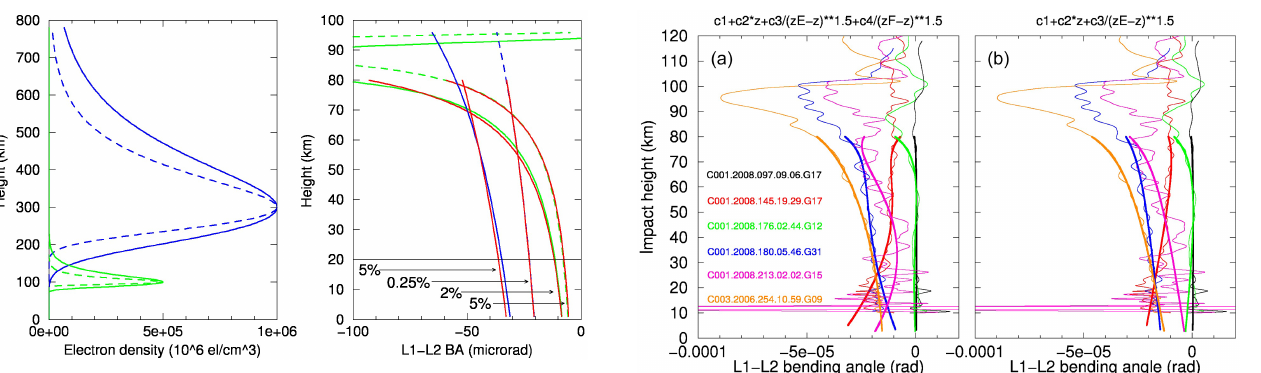
Figure 3. Examples of COSMIC L1–L2 bending angle profiles (thin lines) and fitting functions (thick lines). (a, b) correspond to different models of the fitting